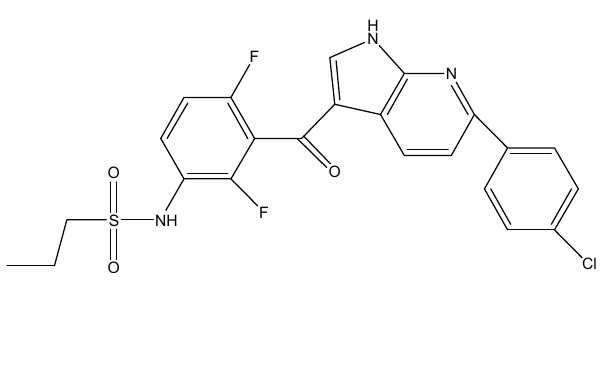
Figure 20. Structure of